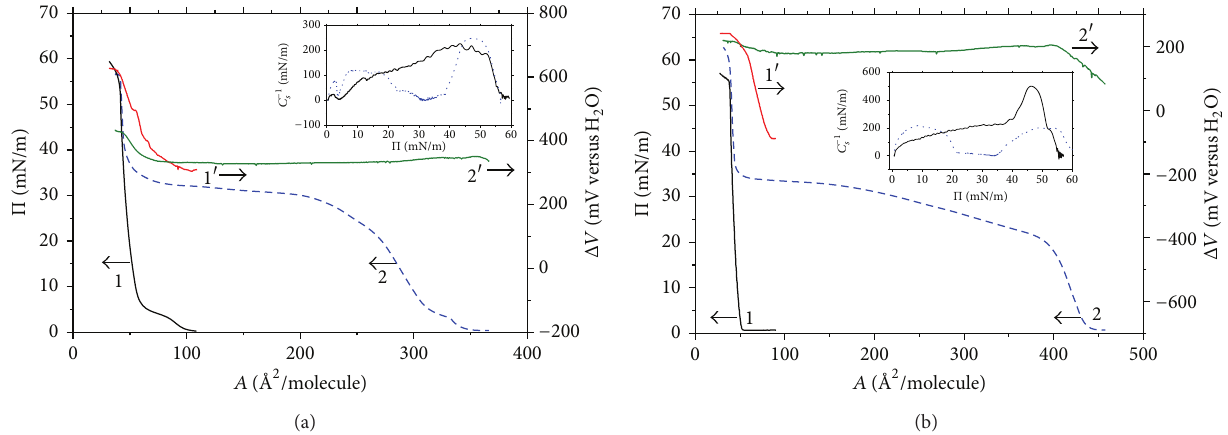
Figure 1: Compression isotherms of surface pressure, Π versus 𝐴 , (curves 1 and 2) and electric surface potential, Δ𝑉 versus 𝐴 (curves 1 󸀠 and 2 󸀠 ) of: (a) DPPC and (b) DPPG monolayers spread on subphase of water (curves 1 and 1 󸀠 ) and lactophoricin (N-23-T) solution, 1 𝜇 M (curves 2 and 2 󸀠 ); “ 𝐴 ” denotes area per the phospholipid molecule. The inserts show the surface compression modulus ( 𝐶 −1 𝑠 ) calculated according to (1) as a function of Π of the pure lipid monolayer (solid lines) and that spread on lactophoricin solution (dotted lines).